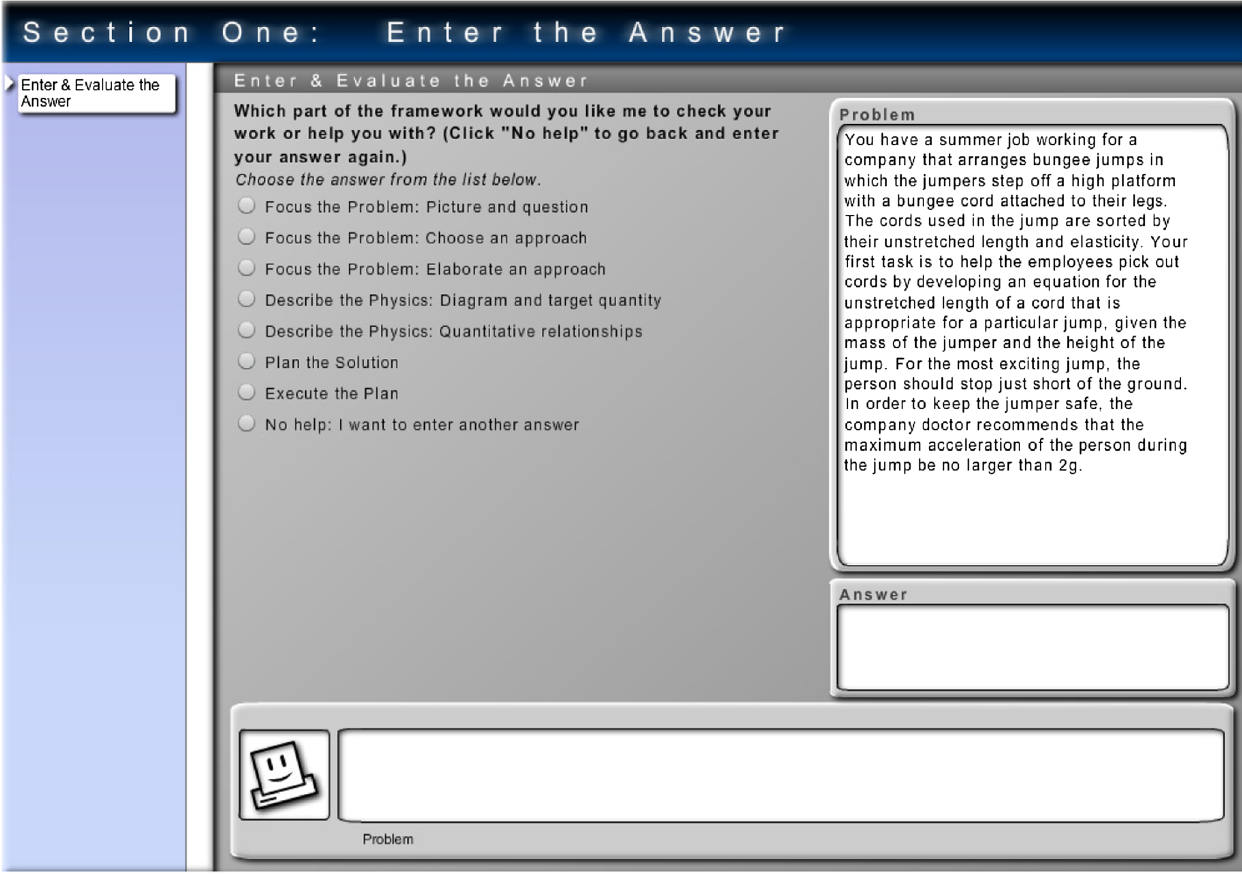
FIG. 3. Screenshot from a type 3 coach (student works independently, computer gives feedback). If the student gets stuck solving a problem or enters an incorrect answer, the computer asks the student to decide where in the problem-solving process the difficulty might occur and to get help.